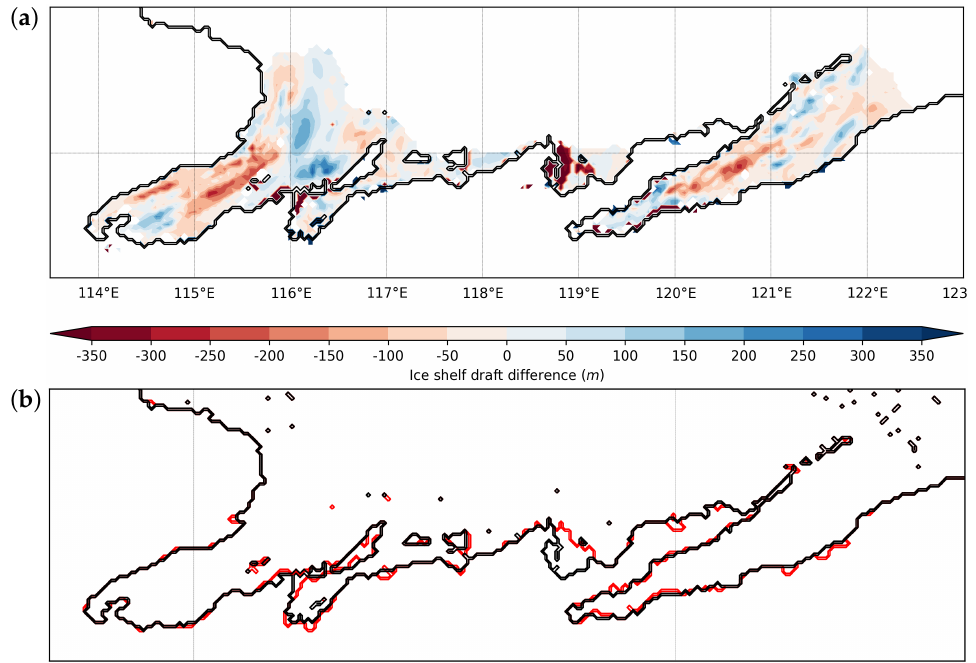
Figure 7. ( a ) Changes in ice shelf draft after 20 years in REF3mcpl. The loss of ice is in red and the gain of ice in blue. The changes are relative to the initial ice shelf draft depth. ( b ) Changes in grounding line position throughout the coupled run. The black and red lines are the initial and final grounding line positions,